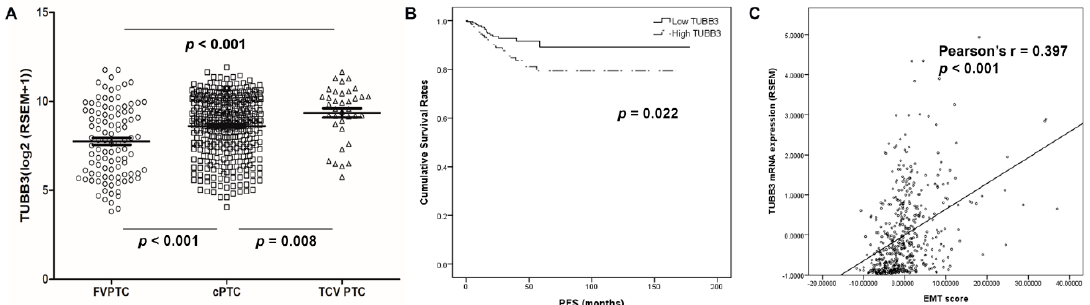
Figure 7. Validation in The Cancer Genome Atlas (TCGA) data. ( A ) TUBB3 mRNA expression was highest in tall cell variant PTC, followed by cPTC and FVPTC. ( B ) Patients with higher TUBB3 mRNA expression showed significantly shorter progression-free survival. ( C ) TUBB3 mRNA expression was correlated with a higher epithelial–mesenchymal transition (EMT) score.